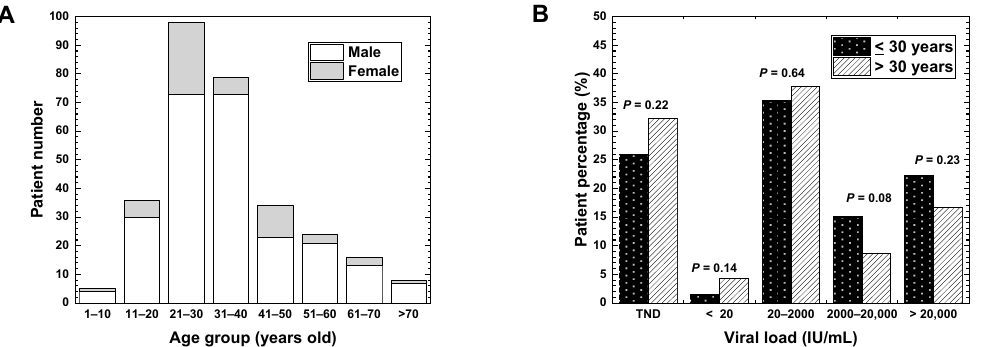
Figure 2. ( A ) HBV patient distribution at di ff erent age ranges. Each column represents the number of HBV patients (open, male; shaded, female) at each age range. The highest number of patients was the age range 21–30 years old, followed by 31–40 years old. ( B ) HBV patient percentages in di ff erent viral load ranges at two age-groups. The patients were categorized into two age-groups; 139 patients were 30 years old or below (filled bar), and 161 patients were above 30 years old (hatched bar). The percentages in two age-groups had no significant di ff erence in any viral load ranges. p values were calculated by the χ 2 test. The HBV patient percentages in each age-group were calculated as follows: % = (Number of patients < 30 years-old or patients > 30 years-old at each viral load range) X100 / [139 samples ( < 30 years-old) or 161 samples ( > 30 years-old)].